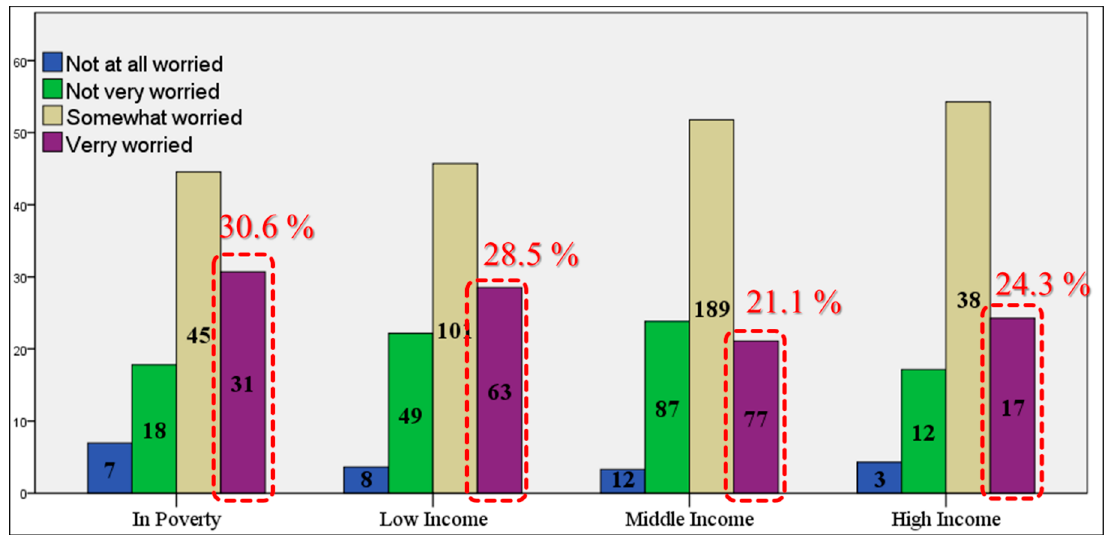
Figure 4. Concern about future impacts of heat waves across income level. The heights of the bars represent percentages, whereas numbers inside the bars represent number of respondents.